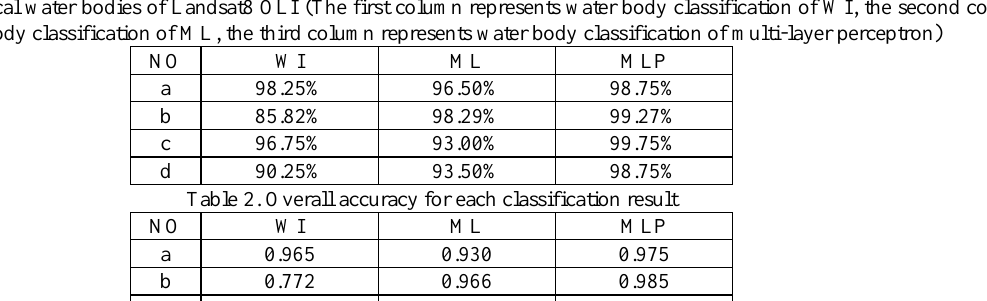
Table 2. Overall accuracy for each classification result